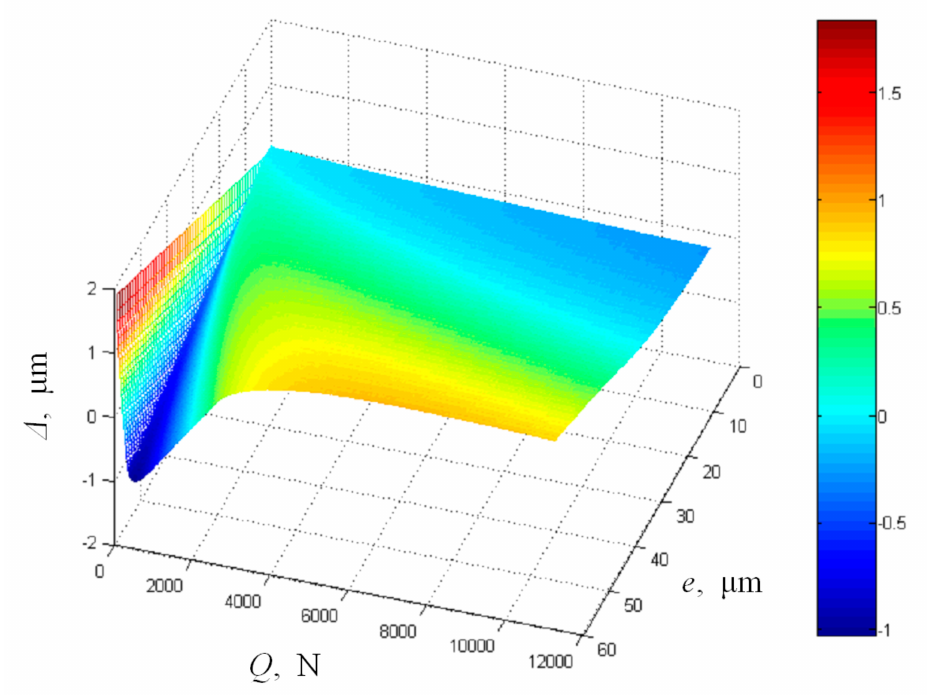
Figure 9. Three-dimensional dependence of the total amplitude of VC vibration ( ∆ ) on the size of internal radial clearance ( e ) and level of external load ( Q ) for the 6206-single-row ball